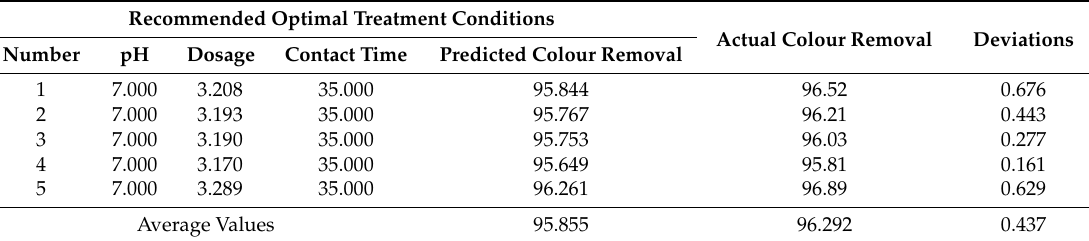
Table 6. Results of the regression model validation by experiments.